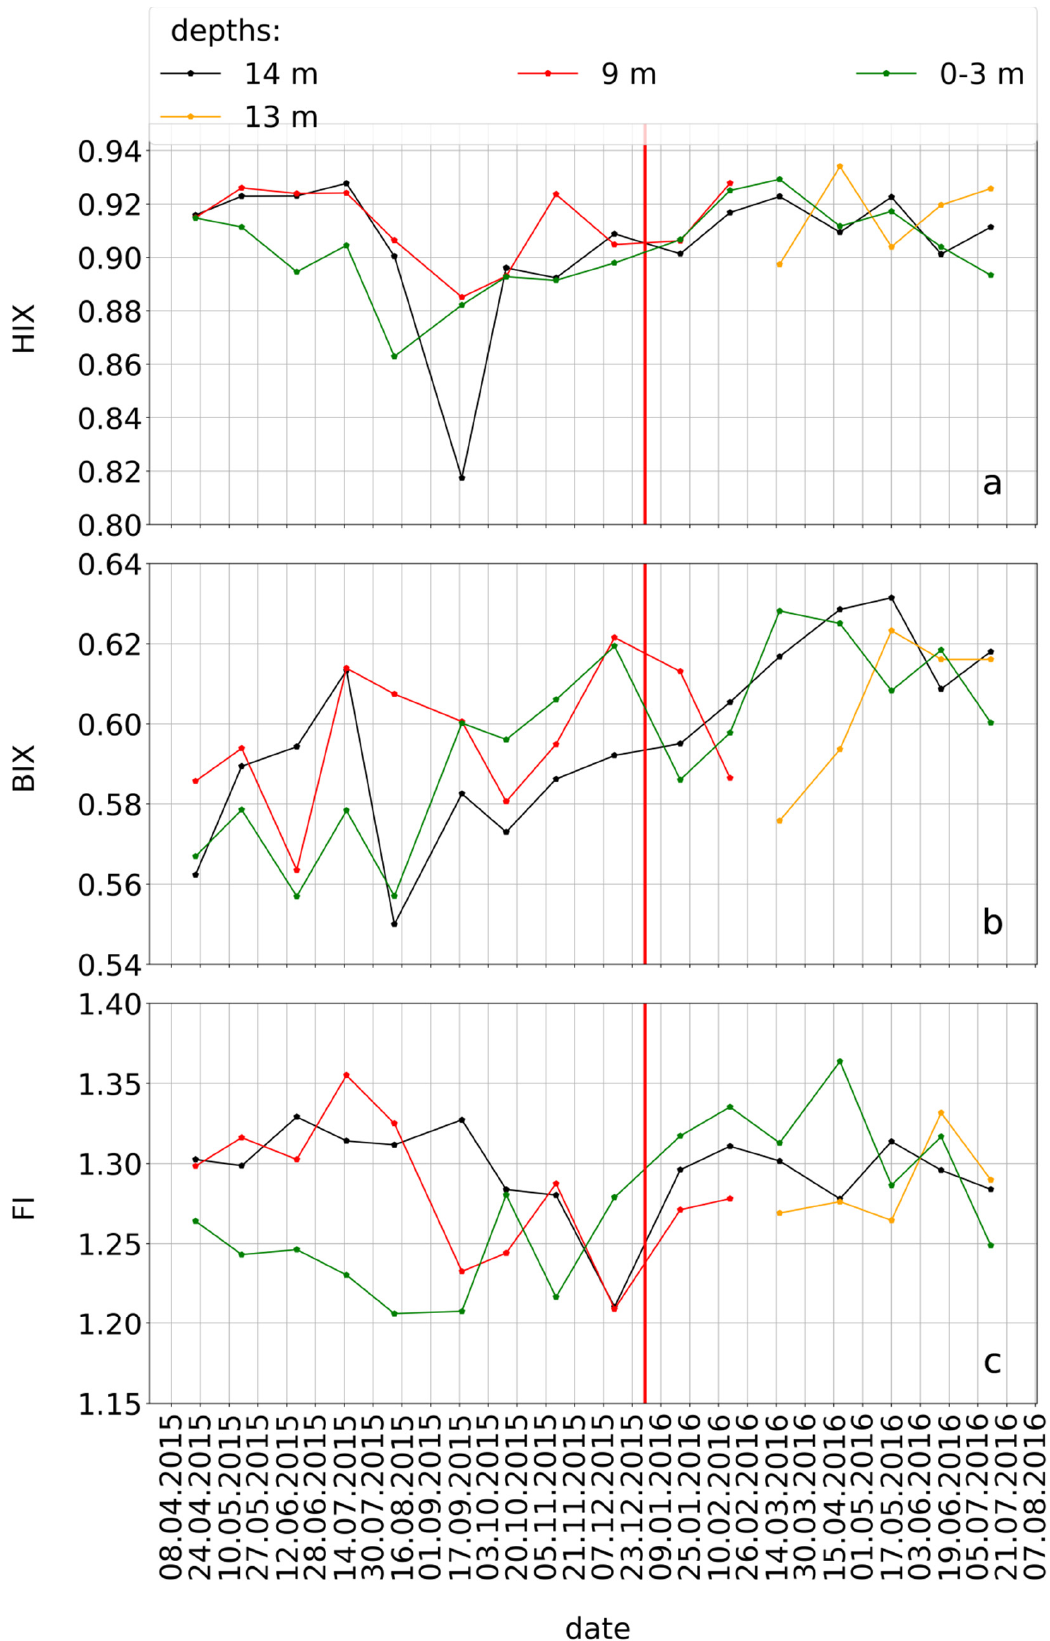
Figure 7. Distribution of HIX ( a ), BIX ( b ), and FI ( c ) at the three relevant depths (bottom: 14 m; mid: 9–13 m and surface water) of the reservoir.